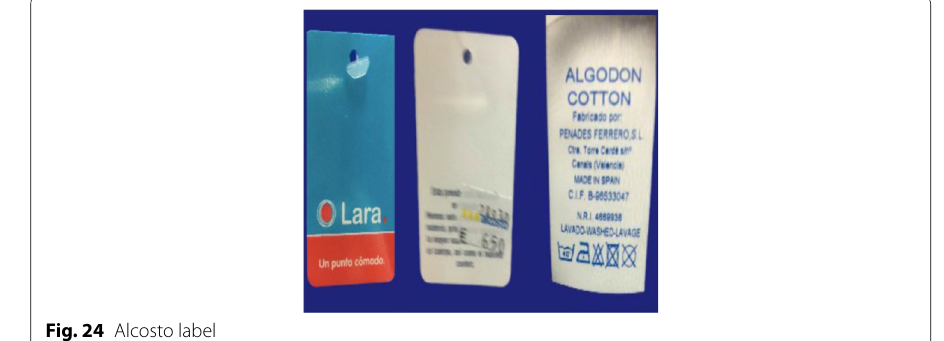
Fig. 24 Alcosto label